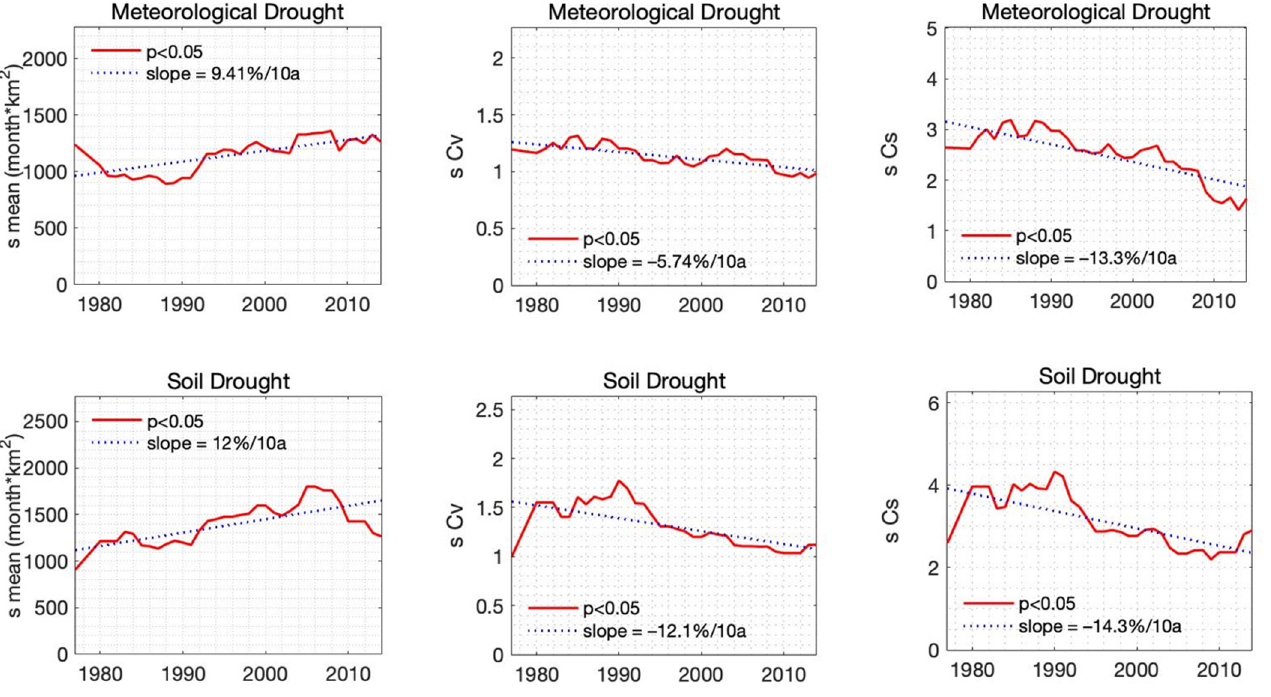
Figure 8. The change in the drought severity